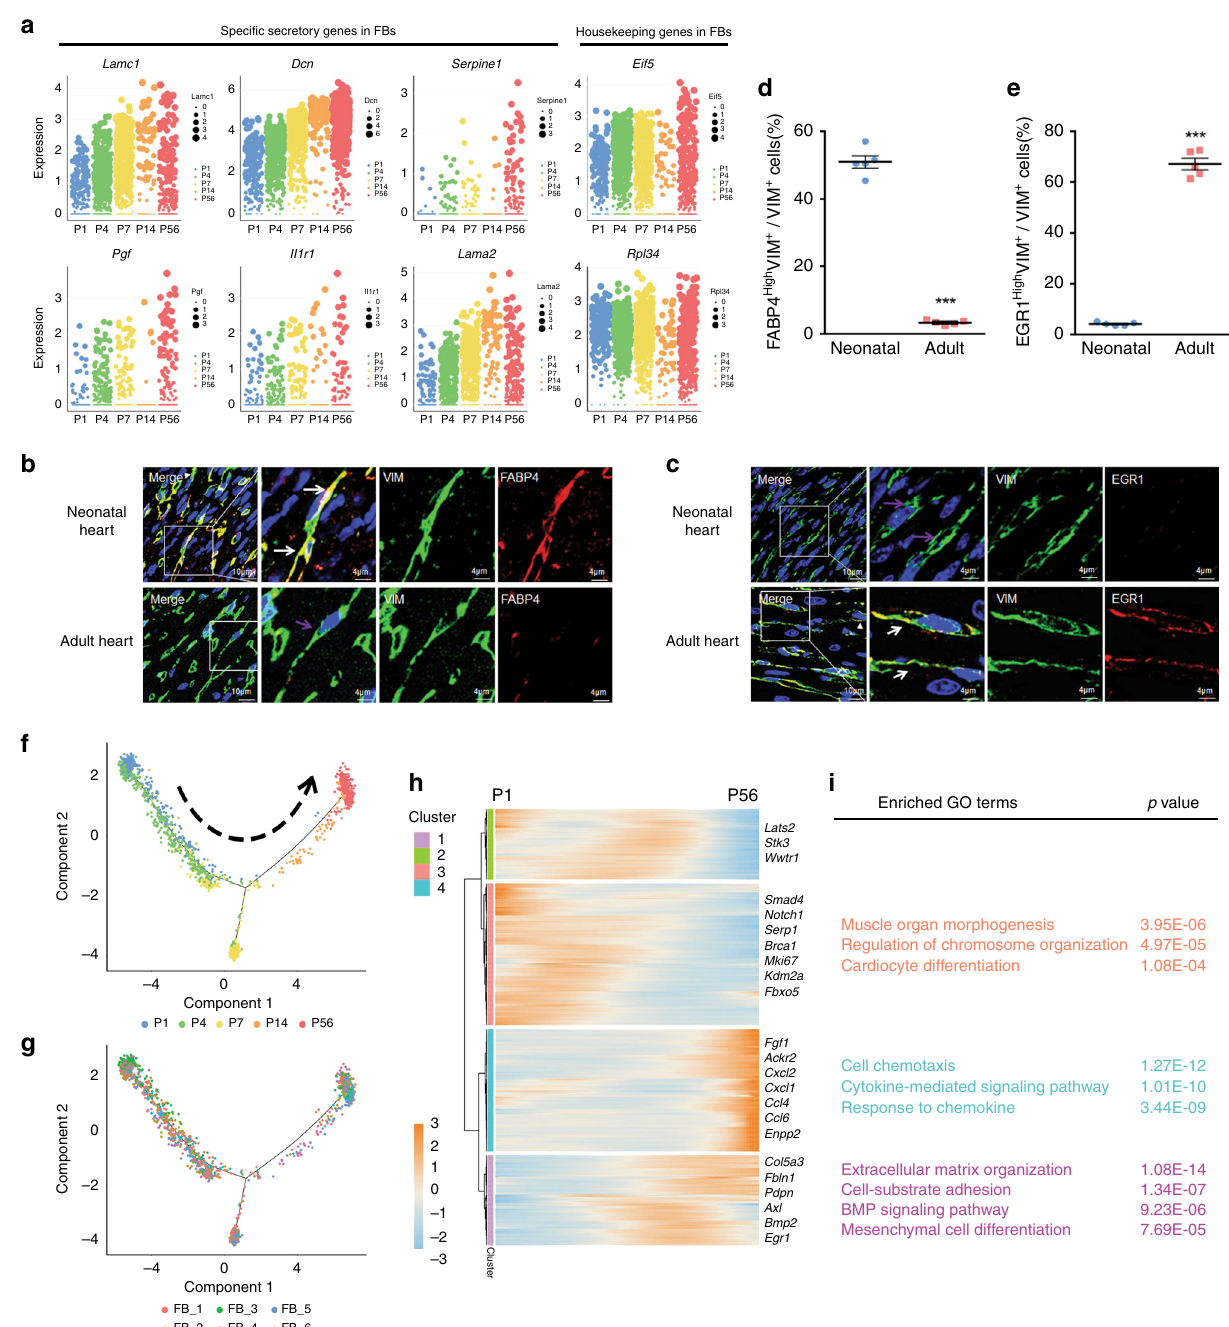
Fig. 3 Subtype switching of cardiac fi broblasts highly correlates with CM maturation. a The expression of selected ligands potentially involved in CM maturation or housekeeping genes in FBs during maturation. b , c Immuno fl uorescent staining of VIM and FABP4 ( b ) or EGR1 ( c ) in neonatal (P1) or adult (P56) heart sections, respectively. White arrows indicate co-localization, purple arrows indicate VIM + only cells. Scale bars = 10 or 4 μ m. d , e Quanti fi cation of VIM + FABP4 High ( d ) or EGR1 High ( e ) cells in heart sections from P1 or P56 mice, Data are plotted as mean ± SEM, n = 5 biologically independent mice, *** p <0.001, two-sided Student ’ s t -test. f , g Monocle analyses showing the ordering of FBs in pseudotime. Each color indicates either a time point ( f ) or a cell state ( g ). h Heatmap to display different blocks of top 1000 differentially expressed genes (DEGs) along the pseudotime trajectory ( f , g ). Please see Supplementary Data 17 for the full list. i Selected top gene ontology (GO) terms related to corresponding DEGs (Supplementary Data 18 – 20). Functional analysis was performed with enrichGO in clusterPro fi ler, p <0.05 was considered signi fi cant enrichment. Source data are provided as a Source Data fi Molecular similarities of in vitro and in vivo CM maturation . (Supplementary Fig. 3j). As a proof of concept, canonical To understand the molecular events giving rise to the observed immature cardiac genes, such as Acta1 , were among the down- morphological and functional maturation of imCMs co-cultured regulated genes in imCM-AF, whereas genes related to CM with AFs, we performed RNA-Seq on imCMs co-cultured with contractility, including Myh6 and Pln , were in the group of NFs (imCM-NF group) or AFs (imCM-AF group), respectively upregulated genes (Fig. 5a). Gene ontology (GO) analysis of genes